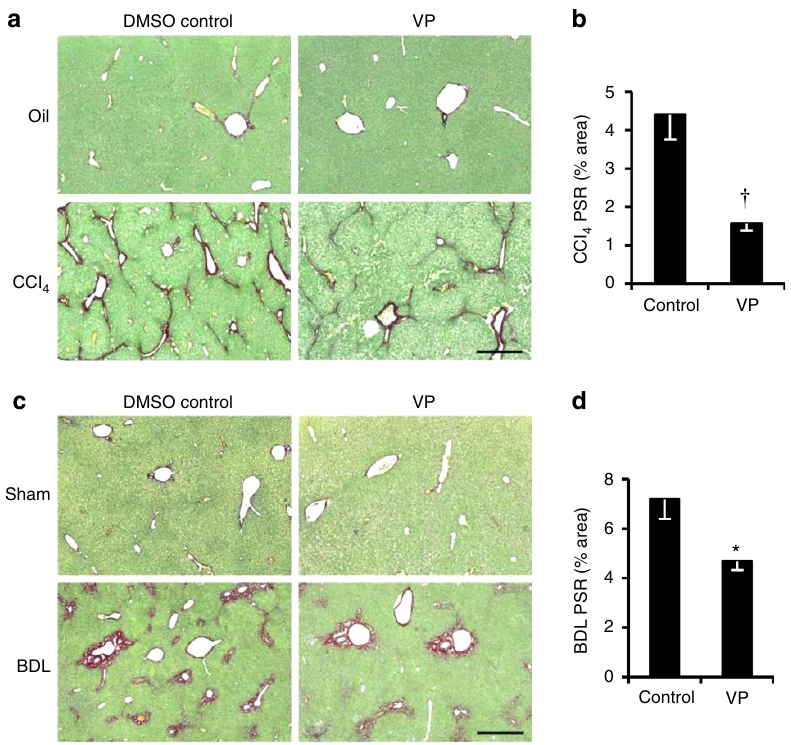
Figure 4 | Pharmacological inhibition of YAP-1 with VP improves liver fibrosis in vivo . ( a ) PSR staining (collagen deposition in red) counterstained with fast green in olive oil control (Oil; top) or chronic CCl 4 -induced fibrosis (bottom) in mice treated with DMSO ( n ¼ 4) or VP (VP; n ¼ 3). ( b ) Quantification of surface area covered by the PSR staining in a . ( c ) PSR staining (collagen deposition in red) in sham-operated mice (Sham; top) or BDL to induce peribiliary fibrosis (bottom) with control DMSO ( n ¼ 7) or VP ( n ¼ 5) treatment. ( d ) Quantification of surface area covered by the PSR staining in c . Scale bar, 500 m m. Liver weight was unaffected in both models treated with VP. Two-tailed unpaired t -test was used for statistical analysis. Data are shown as means ± s.e.m. * P o 0.05, w P o